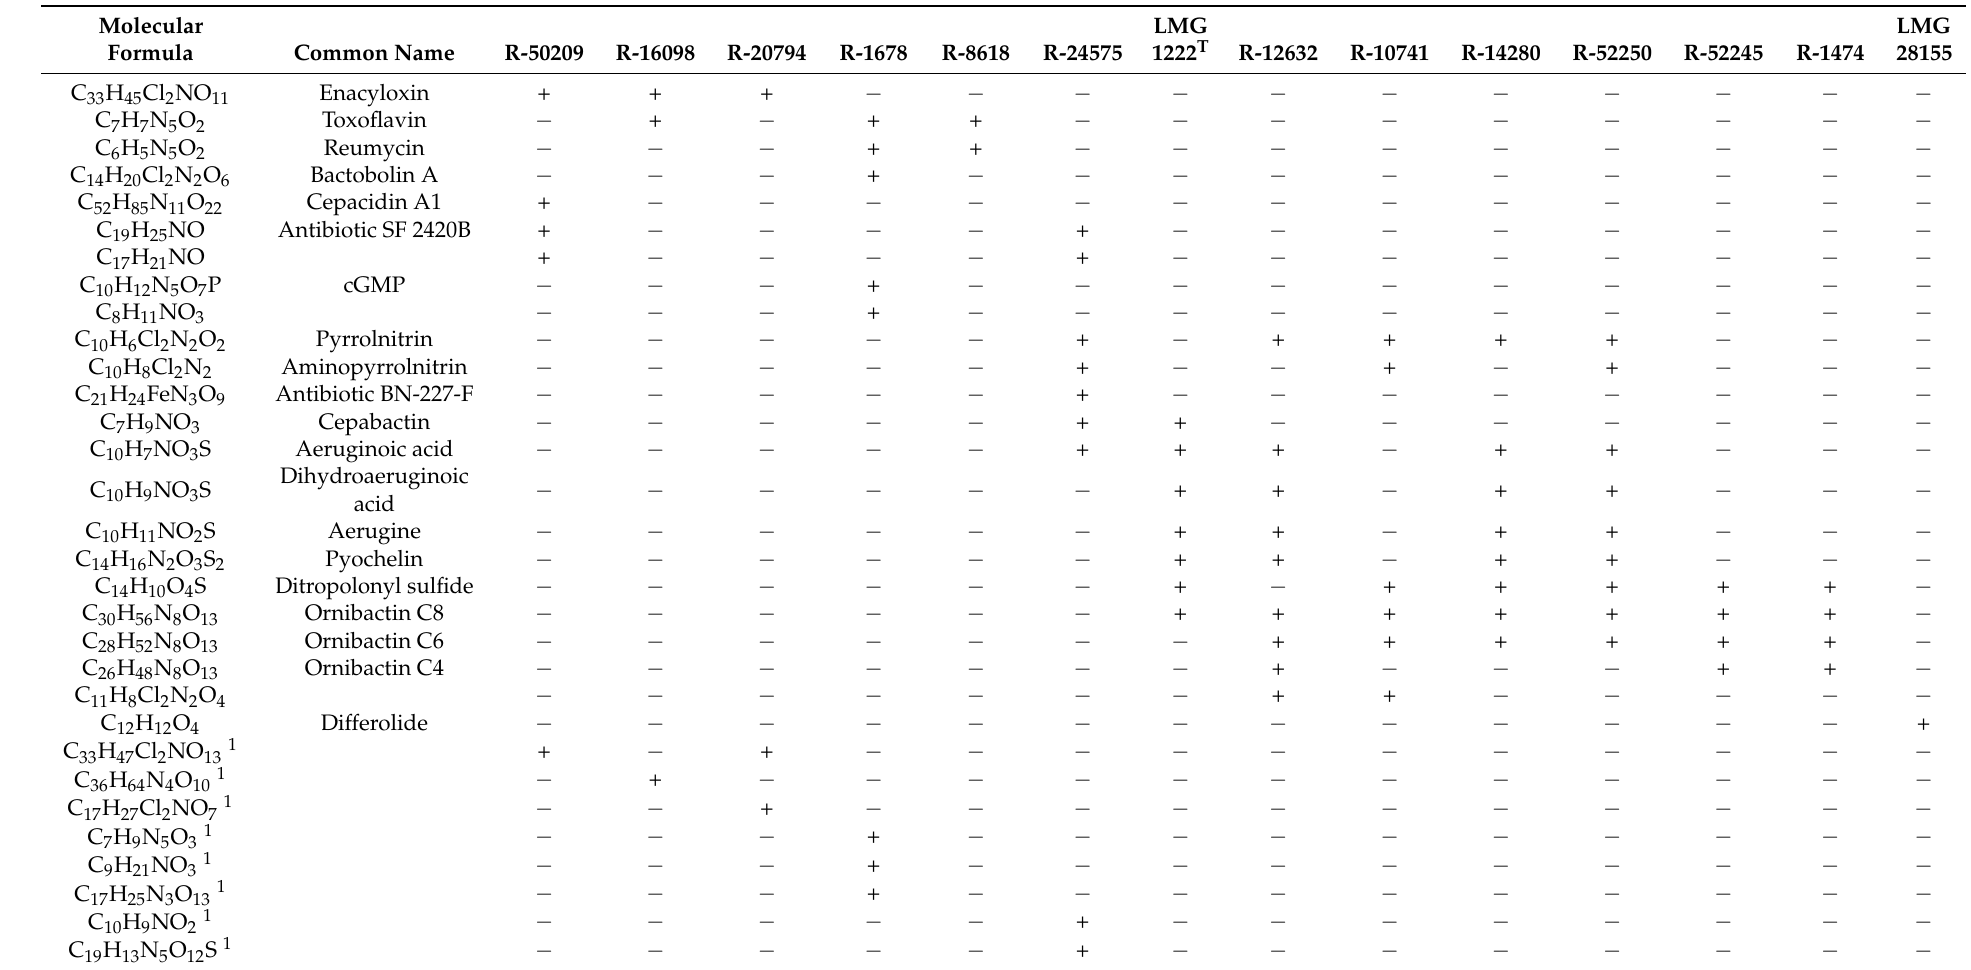
Table 3. Specialized metabolites detected in crude extracts of 14 Burkholderia isolates. +, detected in the crude extract; − , not detected in the crude extract; cGMP, cyclic guanosine monophosphate. Isolates selected for semipreparative fractionation are indicated in bold